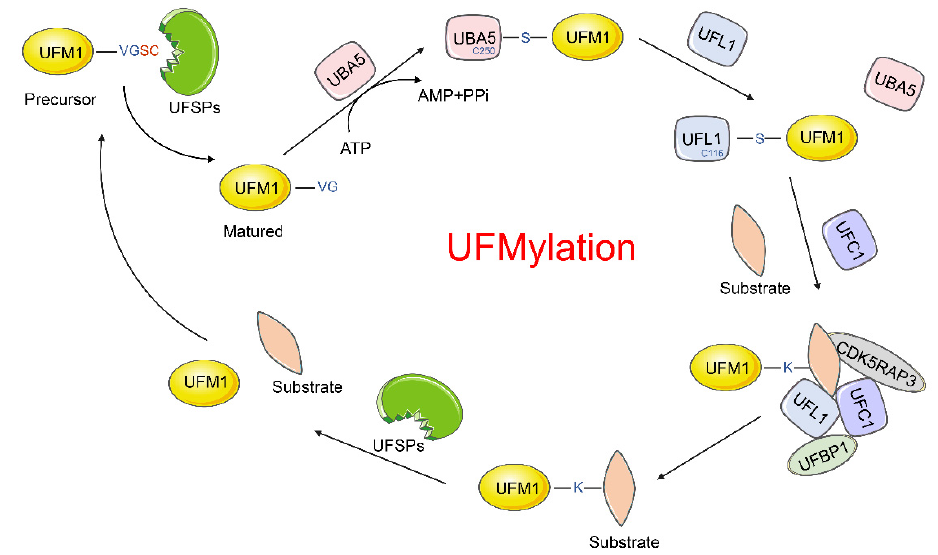
Figure 2. The UFM1 conjugation system. The precursor form of UFM1 is cleaved by UFSPs to expose its C-terminal conserved Gly residue. Then, matured UFM1 is activated by UBA5 that consumes ATP, forming a high energy thioester bond with Cys250 of UBA5. UFC1 next binds to UBA5 and retrieves UFM1 from UBA5 by forming a thioester bond with UFM1. Finally, UFC1, together with UFL1, transfer UFM1 to its substrate. Both UFBP1 and CDK5RAP3 are possible adaptor proteins that allow the ligase UFL1 to recruit a wider pool of substrates. Additionally, since UFMylation is a reversible process, the UFM1 molecules can be removed from their targets by UFSPs. Abbreviation: VGSC is an amino acid motif (valine–glycine–serine–cysteine). S indicates the thioester bond. K represents the lysine residue of the substrate.